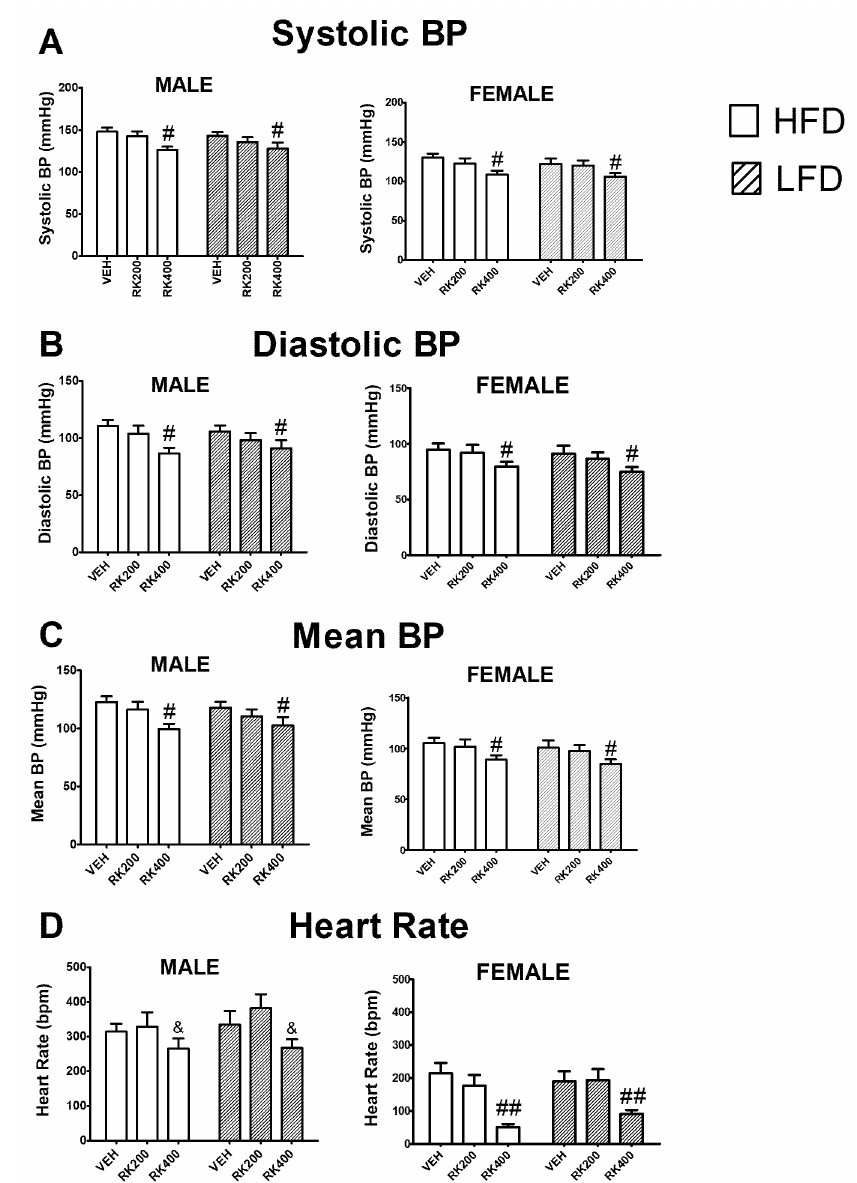
Figure 6. Hemodynamic measurements during the last two days of the 14-day daily oral RK and diet access. Blood pressure and heart rate were measured by noninvasive tail-cuff method. Data are represented as means ± standard error of the mean (SEM). High-fat diet (45% fat; HFD, solid lines) and low-fat diet (10% fat; LFD, stripped line) and oral dosed with raspberry ketone (RK) or vehicle (50% propylene glycol, 40% water, and 10% dimethyl sulfoxide; DMSO) for 14 days. Comparisons are separate within each sex. Hemodynamic measurements were averages over the last 2 days of dosing and diet exposure. ( A ): Systolic blood pressure (mm Hg), ( B ): diastolic blood pressure (mm Hg), ( C ): mean blood pressure (mm Hg), ( D ): heart rate (beats per minute; BPM). # indicates overall dose difference from vehicle and RK 200 mg/kg ( p < 0.05), ## indicates overall dose difference from vehicle and RK 200 mg/kg ( p < 0.005) & indicates overall dose difference from RK200 dose ( p < 0.05). HFD-Vehicle (males: n = 12, females n = 12), HFD-RK (200 mg/kg) (males: n = 12, females: n = 11), HFD-RK (400 mg/kg) (males: n = 11, females: n = 11), LFD-Vehicle (males: n = 11, females: n = 11) LFD-RK (200 mg/kg)(males: n = 11, females: n = 11), and LFD-RK (400 mg/kg) (males: n = 11, females: n = 12).